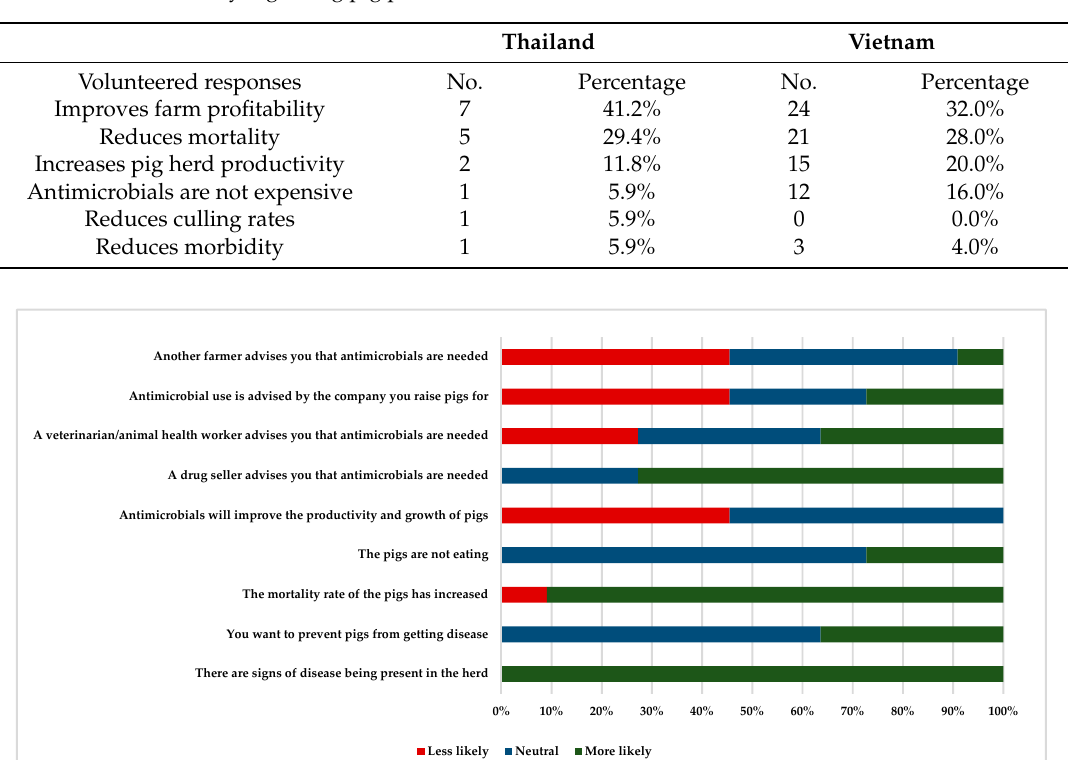
Table 7. Characteristics of antimicrobials used in a case study in antimicrobial use in pig production in Thailand and Vietnam.